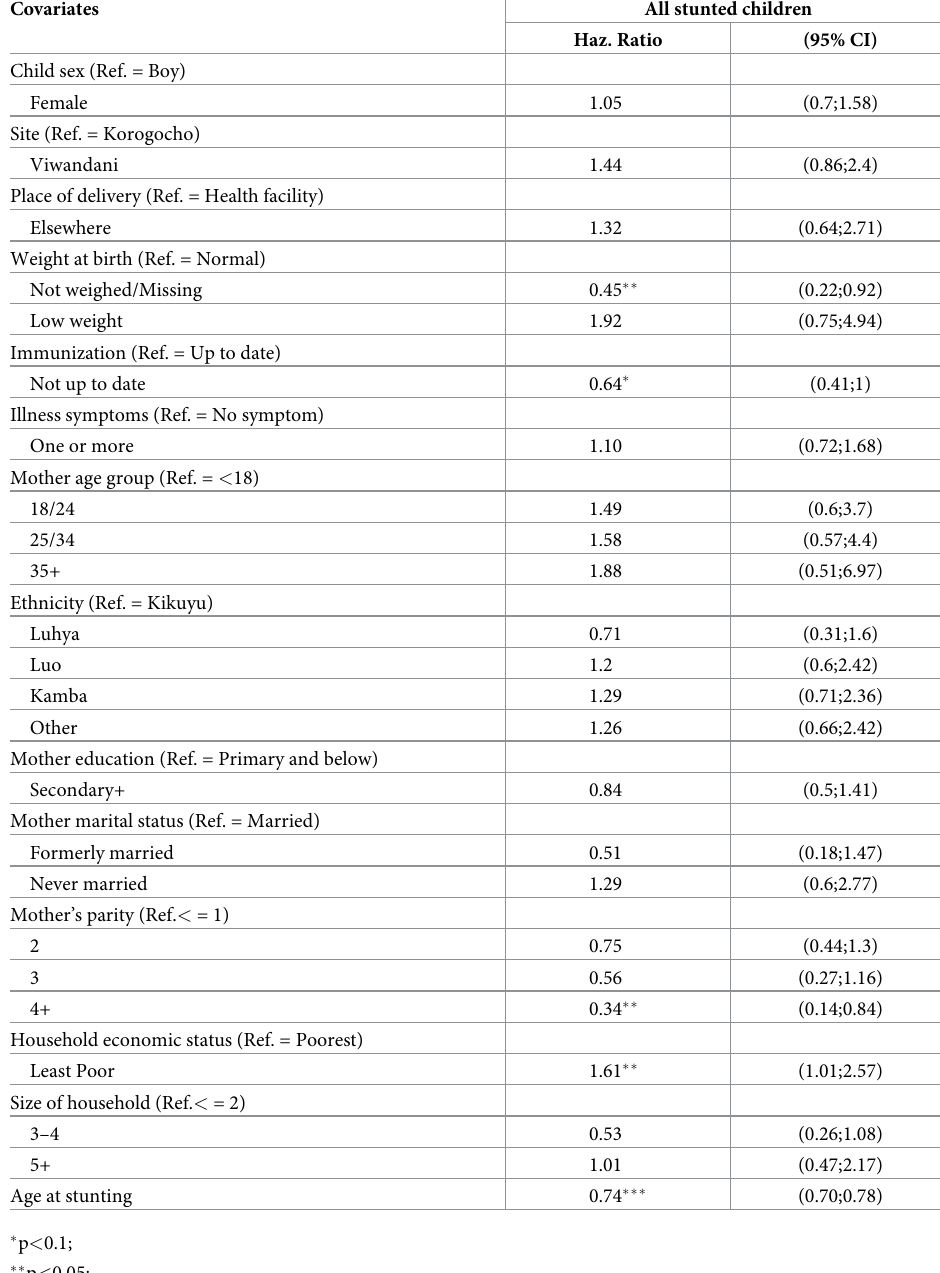
Table 3. Adjusted hazard ratios from Cox regression model predicting the chance of recovery from stunting. Covariates All stunted